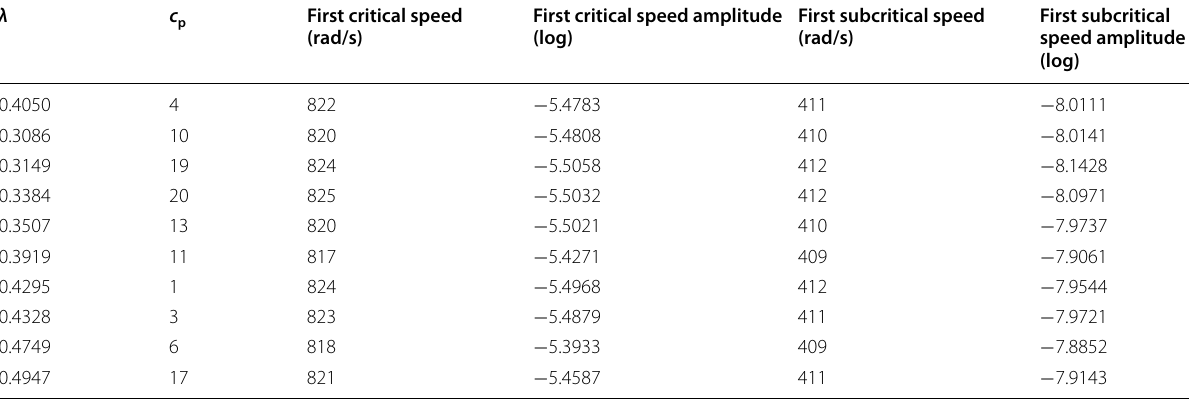
Table 2 Part of the data used to train the RBF network λ